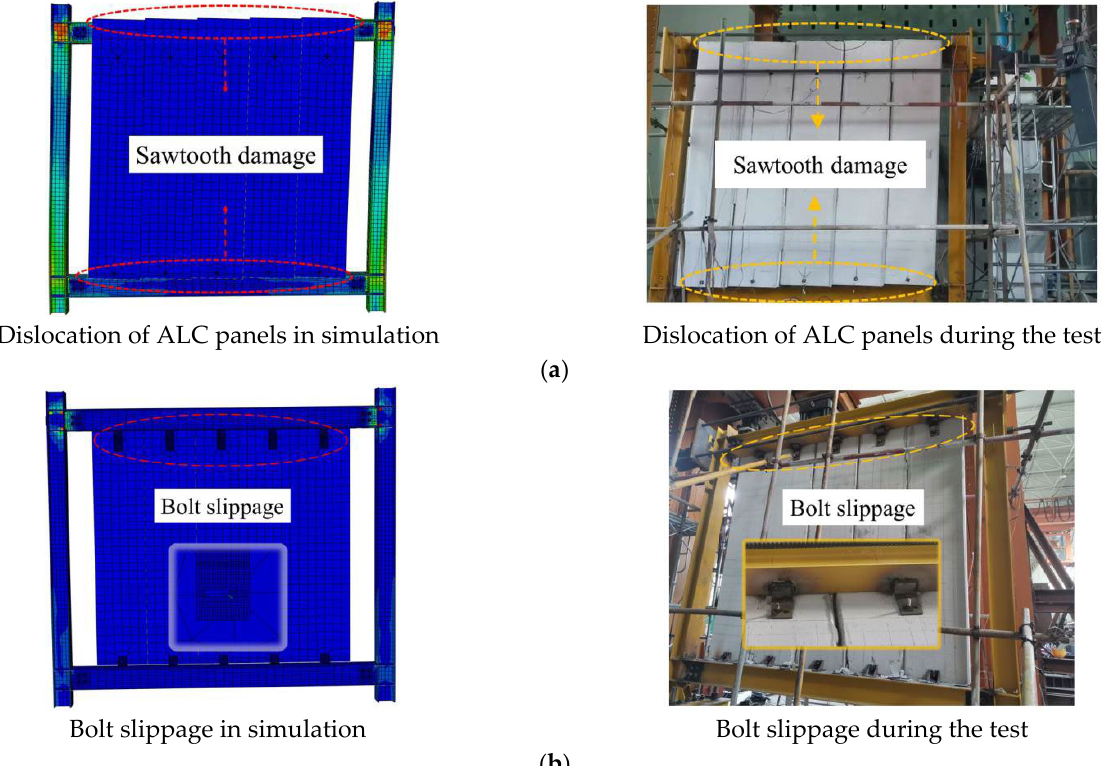
Figure 19. Comparison of test and simulation data. ( a ) Hysteresis curves of simulation and experi- ment. ( b ) Skeleton curves of simulation and experiment.